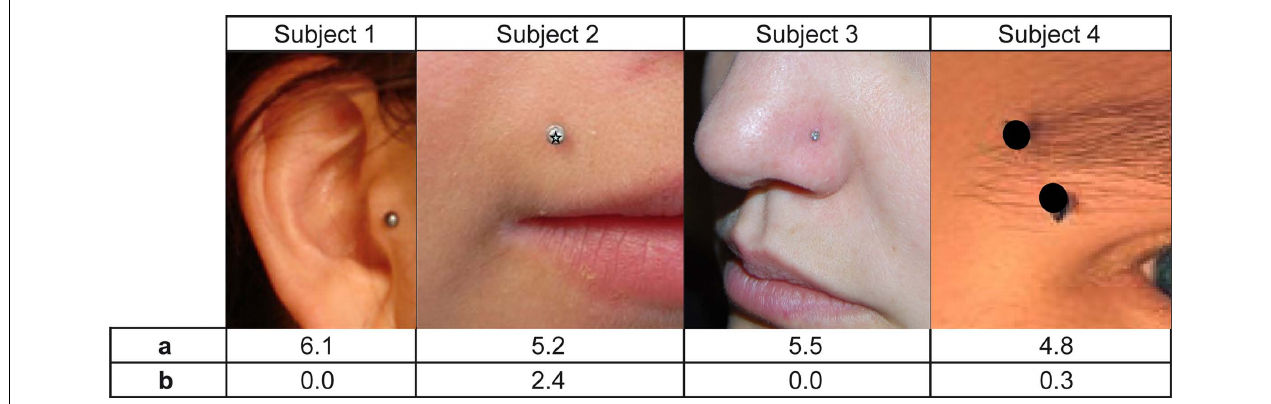
FIGURE 1 | Pierced jewelry on the face of each subject. Pain score evaluated with a subjective analogical scale on the first day before the jewelry was removed (A) , and when each subject was checked on average 3weeks later without the jewelry (B) .